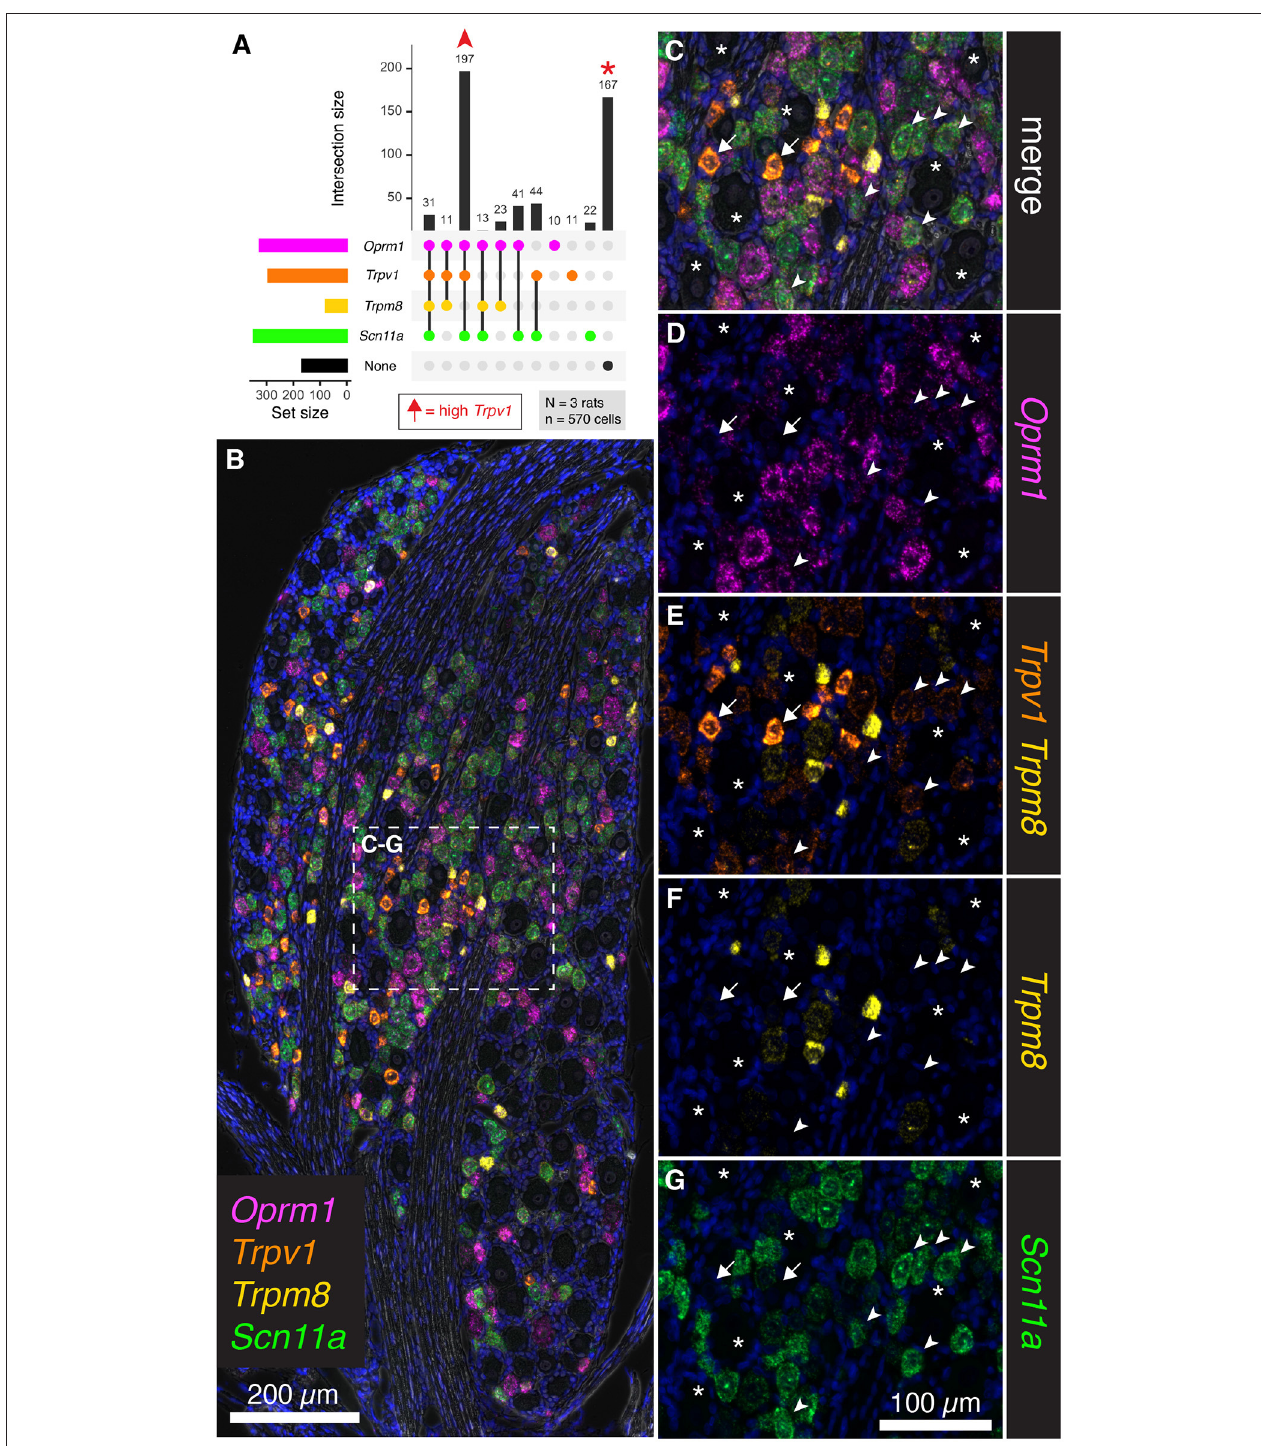
FIGURE 7 | Co-expression analysis for Trpv1 , Trpm8 , Oprm1 , and Scn11a . To further assess the overlap between nociceptive transducing ion channels and opioid receptors, multiplex fluorescent hybridization was performed for Trpv1 , Trpm8 , Oprm1 and Scn11a in N the mRNA coding for the cold-pain transducing nociceptive ion channel Trpm8 as well as the mRNA encoding the voltage-gated ion channel subunit Scn11a. (A) Counts were tabulated for co-expression of these four markers as before. The most prevalent group were neurons co-positive for Trpv1 , Oprm1 and Scn11a (197 cells). Notably, a large number of neurons was also unlabeled (167 cells). Arrows in the plot in (A) are used to identify cells in the representative fields in subsequent panels. High Trpv1 neurons (arrows) are not in the plot in (A) , but were highlighted in the representative fields. (B) A panoramic stitched image is shown to